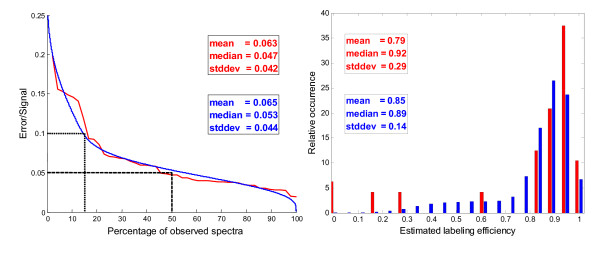
Simulated data mimicking experimental distributions. a) The error to signal ratio (ε/S-ratio) displayed shows that 85% of the experimentally observed spectra (red line) matched the theoretical reconstruction well, with less than 10% of the total spectral intensity assigned to the error term (dotted line). 50% of the spectra were matched very well with less than 5% error (dashed line). Noise was introduced into the simulated spectra in order to reflect a similar ε/S-ratio distribution (blue line). b) The labelling efficiency was found to vary considerably between experimental spectra (red bars). One peptide was not labelled at all, while another was completely absent in the treated sample, which produced the three spectra with a labelling efficiency of zero observed. The simulated spectra were generated to reflect this long tailed and high variability distribution (blue bars).